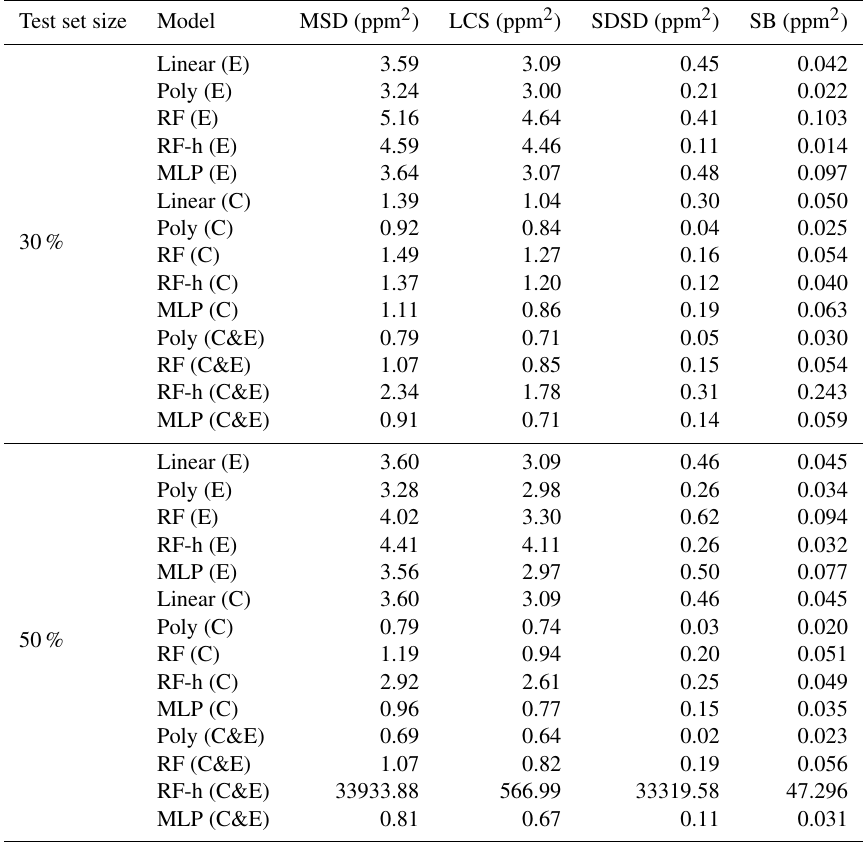
Table A2. MSD decomposition for the different configurations and both test set sizes considering Figaro ® TGS sensors and environmental variables as input. Notation is the same as in Table A1.